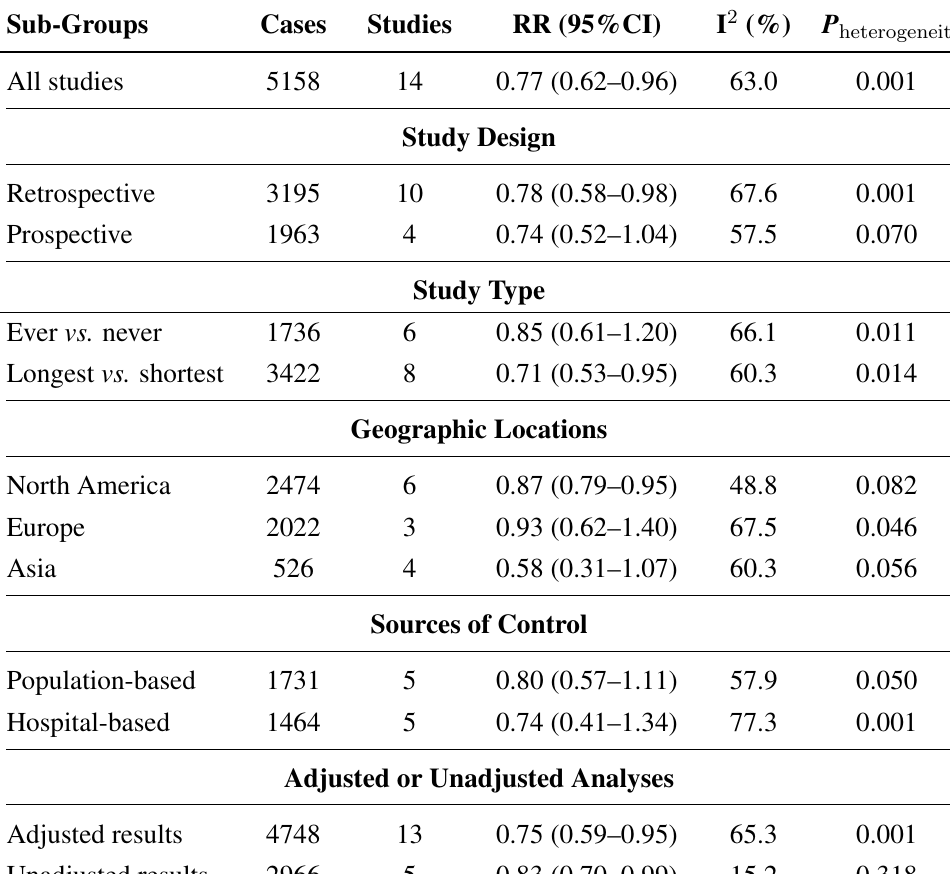
Table 2. Summary risk estimates of the association between breastfeeding and endometrial cancer